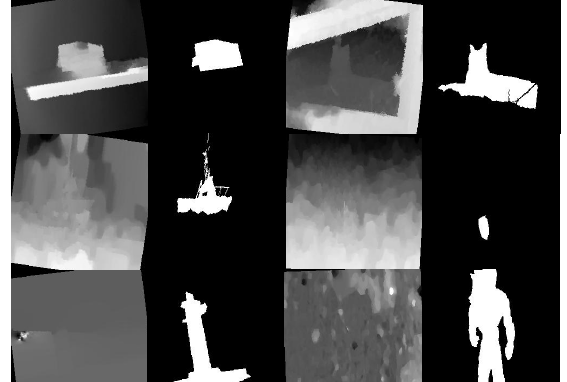
Figure 4. Low quality depths in